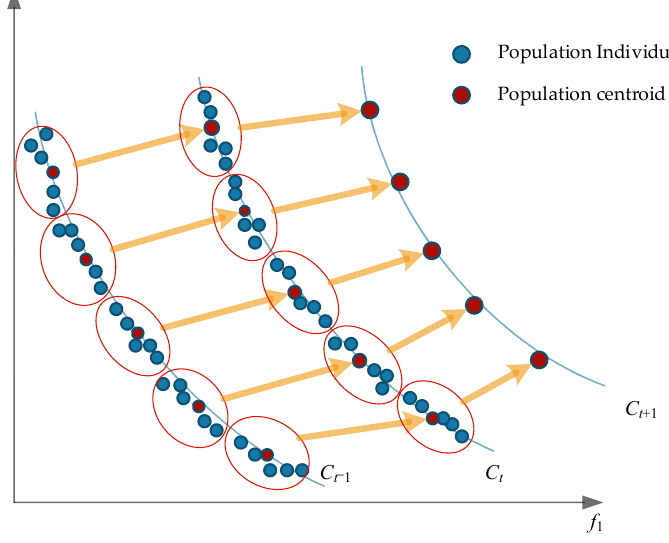
Figure 3. Classification of clustering Figure 3. Classi fi cation of clustering dynamics.